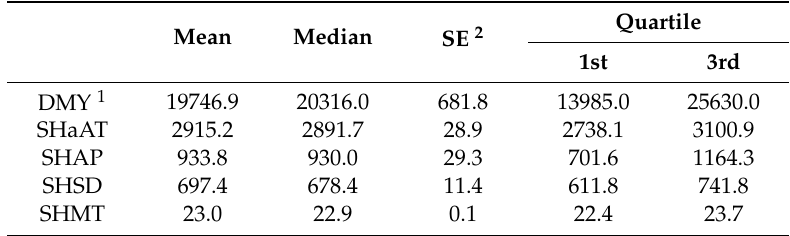
Table 3. Descriptive statistics for all the variables in the sorghum–sudangrass hybrid